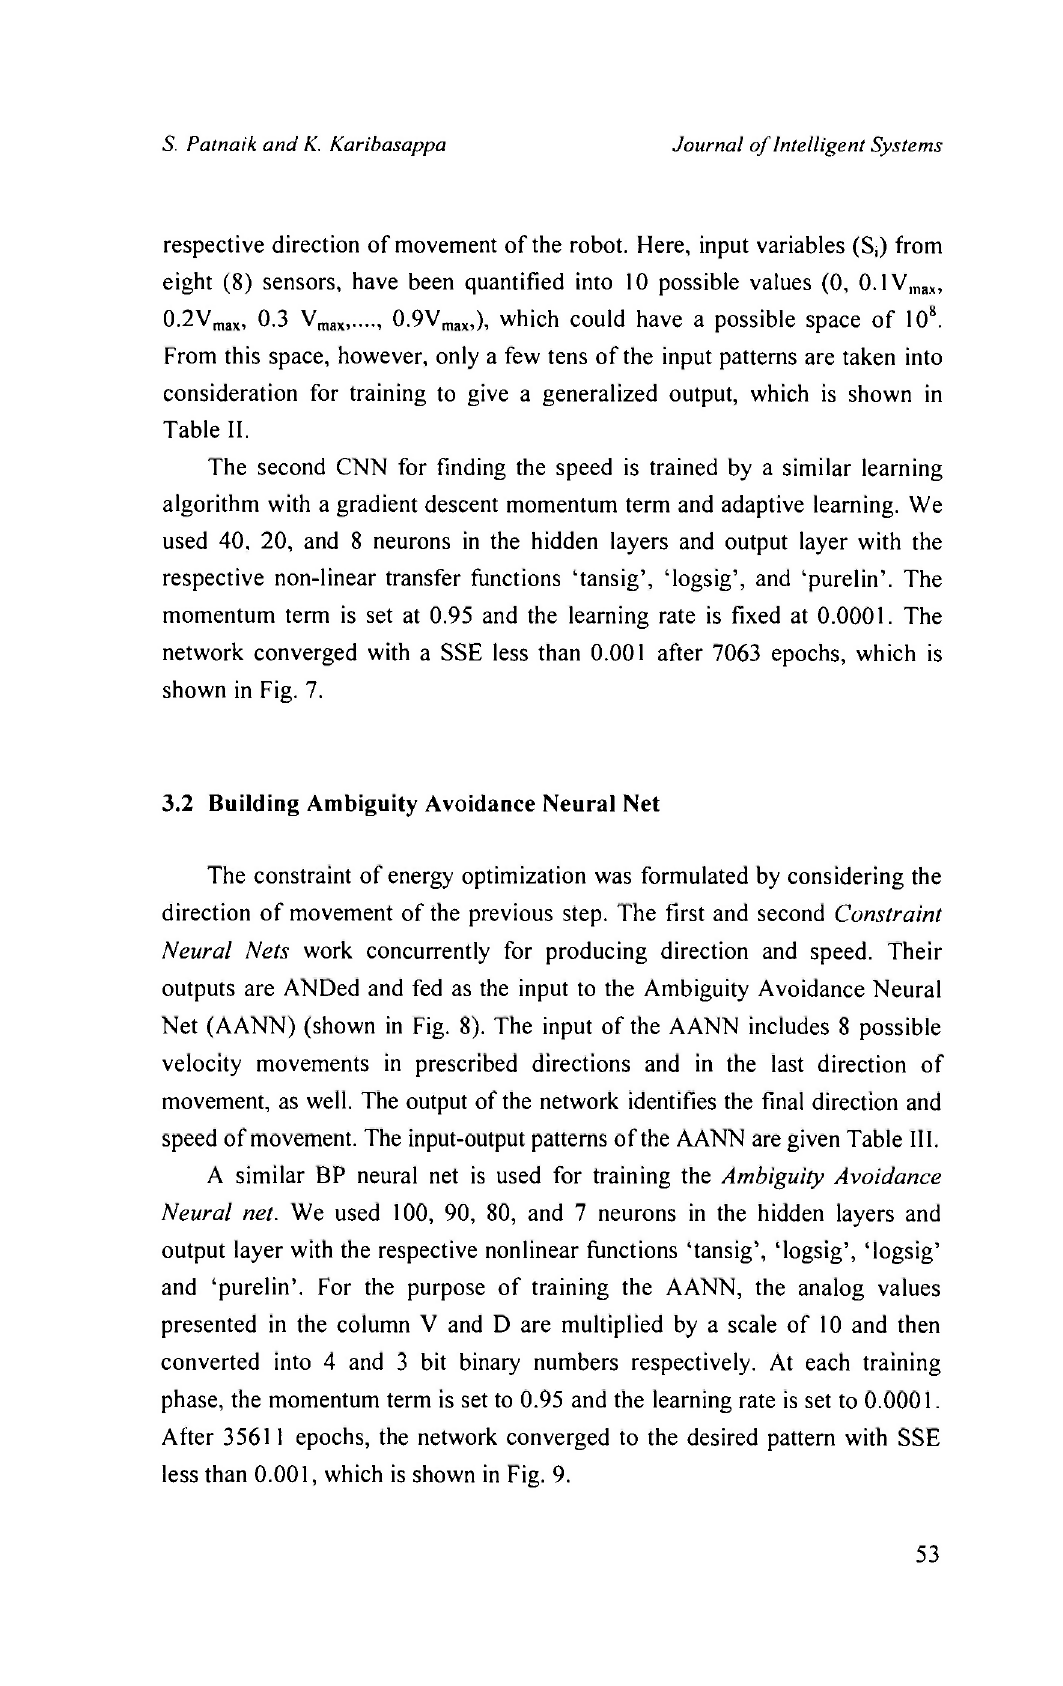
respective direction of movement of the robot. Here, input variables (Sj) from eight (8) sensors, have been quantified into 10 possible values (0, 0.1V,„ ax